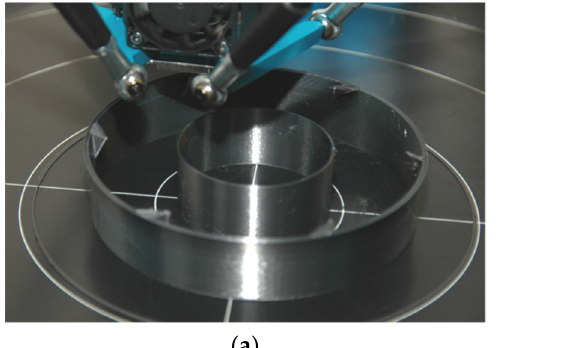
Figure 10. Concept model printing of the impeller of a submersible electric pump through FDM technology by using PET as base material: ( a ) during and ( b ) after.